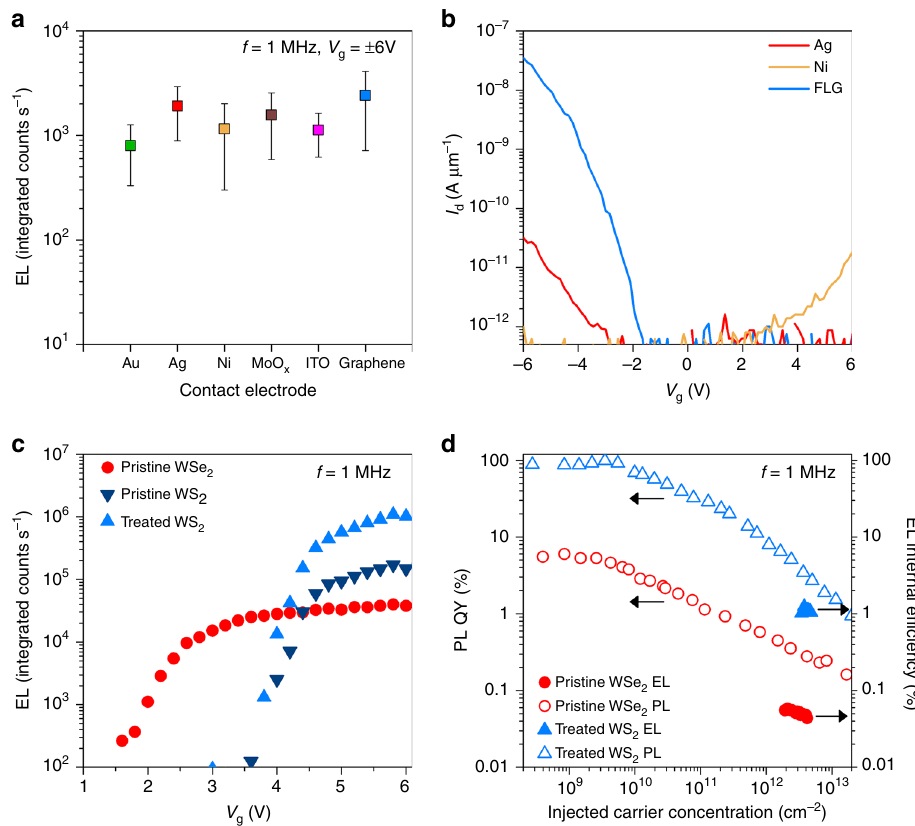
Fig. 3 Contact and voltage dependence. a EL from WSe 2 devices fabricated using various source contacts. Error bars indicate standard deviation of EL intensity measured from fi ve or more different devices. b I d – V g characteristics of WSe 2 devices contacted by Ag, Ni, and few-layer graphene source electrodes. c Voltage dependence of EL for WSe 2 and WS 2 devices (WS 2 before and after superacid treatment). d PL QY and EL internal ef fi ciency measured for a WSe 2 device and a superacid-treated WS 2 device as a function of injected carrier